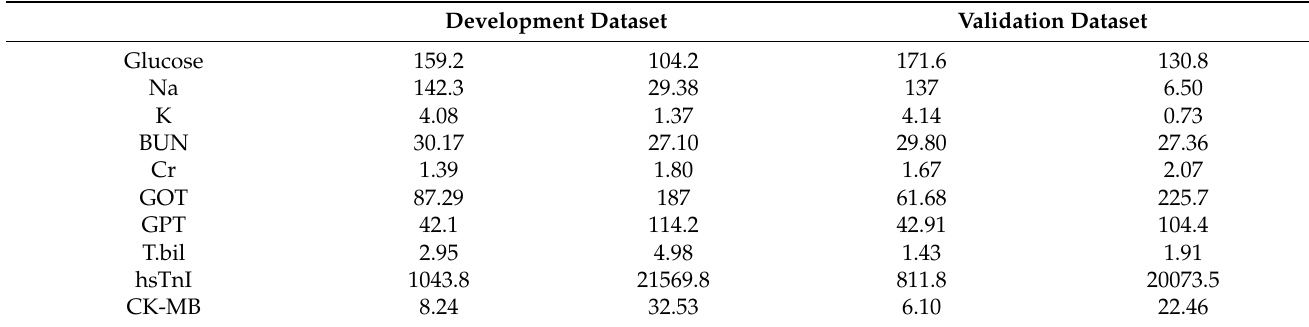
Table 2. Cont. Development Dataset Validation Dataset